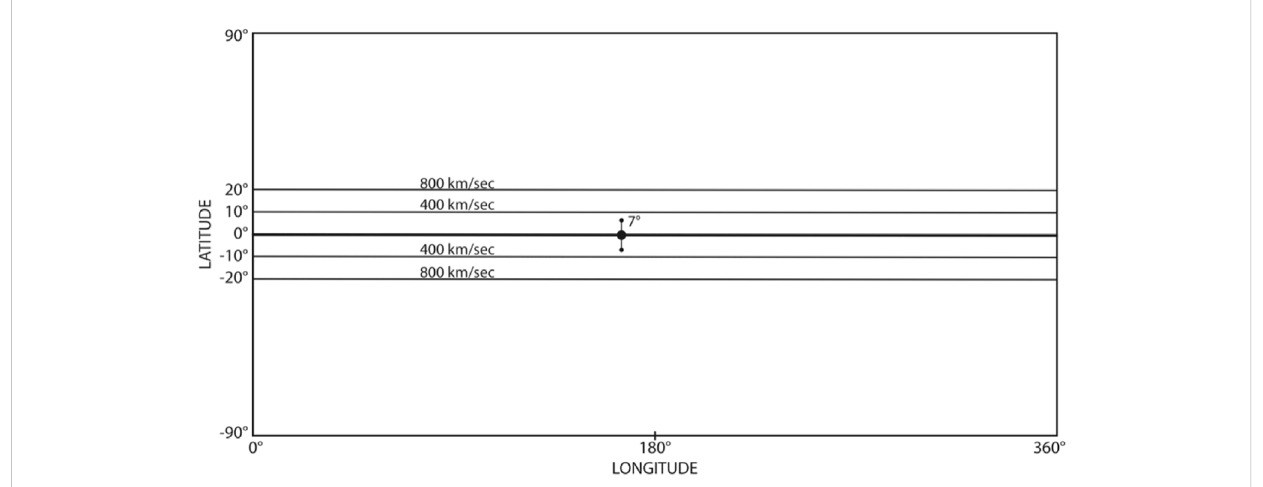
FIGURE 7 The speed distribution of the solar wind during the solar minimum period in the Carrington map. This is an approximate graphic representation of Figure 1, except the equatorial streamer. The Earth ’ s location is projected on the ecliptic plane.